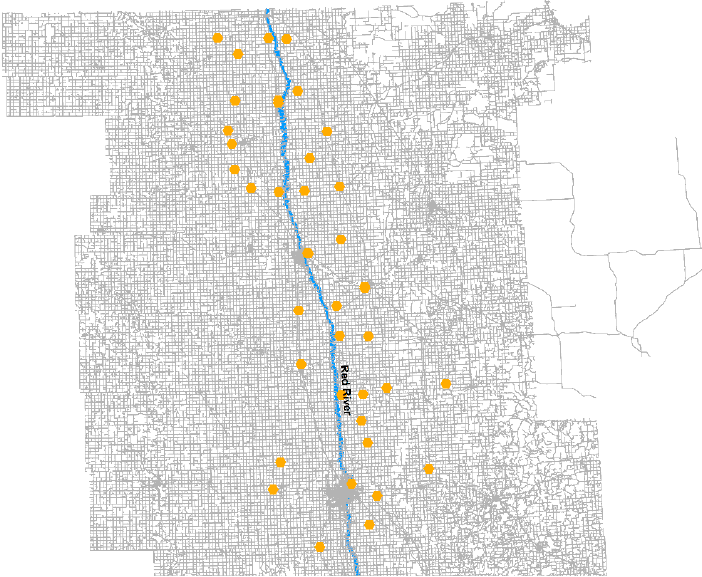
Figure 4. Red River Valley road network and piler locations.